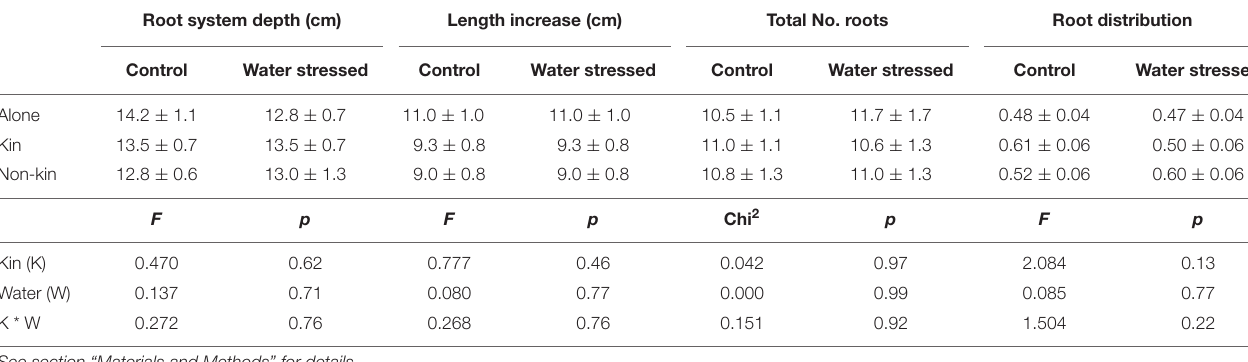
TABLE 2 | Root parameters (means ± SE) measured at the final harvest in Experiment 1 and statistical outputs. Root system depth (cm) Length increase (cm) Total No. roots Root distribution